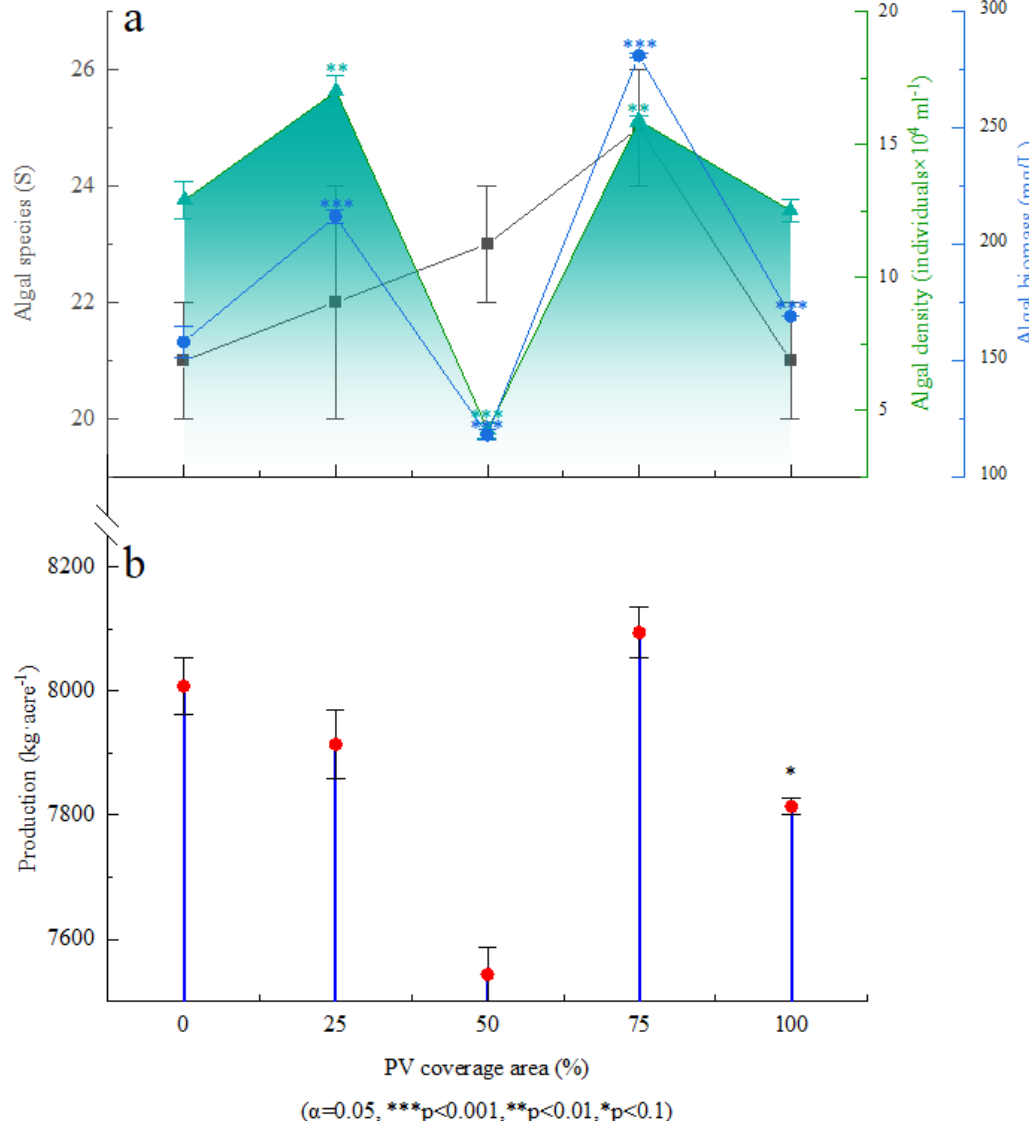
Figure 6. Impact of photovoltaic coverage area on phytoplankton and fish. ( a ) Changes in algal species and algal density and algal biomass under different PV coverage area, ( b ) Changes of Pelteobagrus fulvidraco production under different PV coverage area.